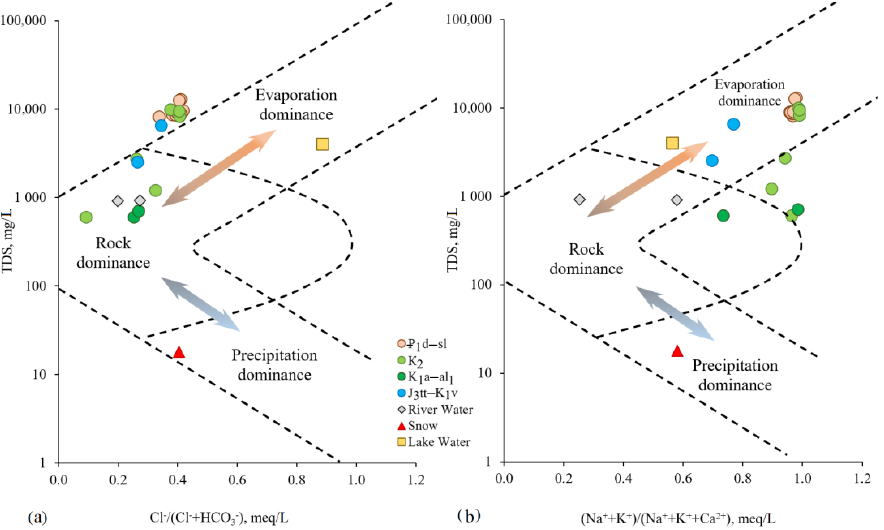
Figure 7. Gibbs diagram of natural mineral waters samples: ( a ) anion ratio (Cl − /(Cl − +HCO 3 − ); ( b ) cation ratio (Na + +K + )/(Na + +K + +Ca 2+